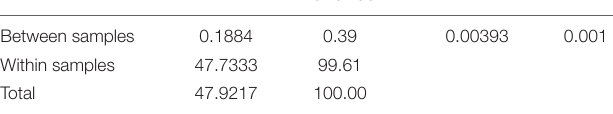
TABLE 2 | AMOVA results.